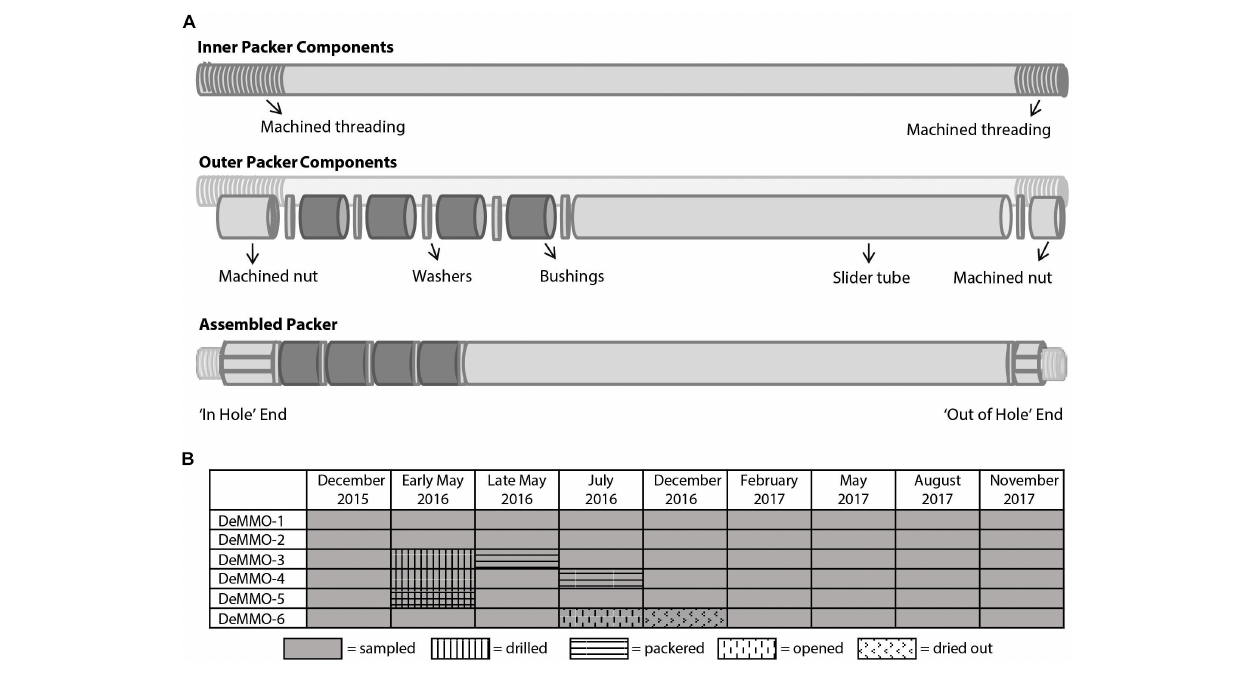
FIGURE 1 | (A) Packer design used to modify DeMMO 3, 4, and 5 illustrating the inner components, outer components, and assembled design. Dark gray bushings are expanded to create the seal with the borehole. (B) Timeline of sampling and hole modification.